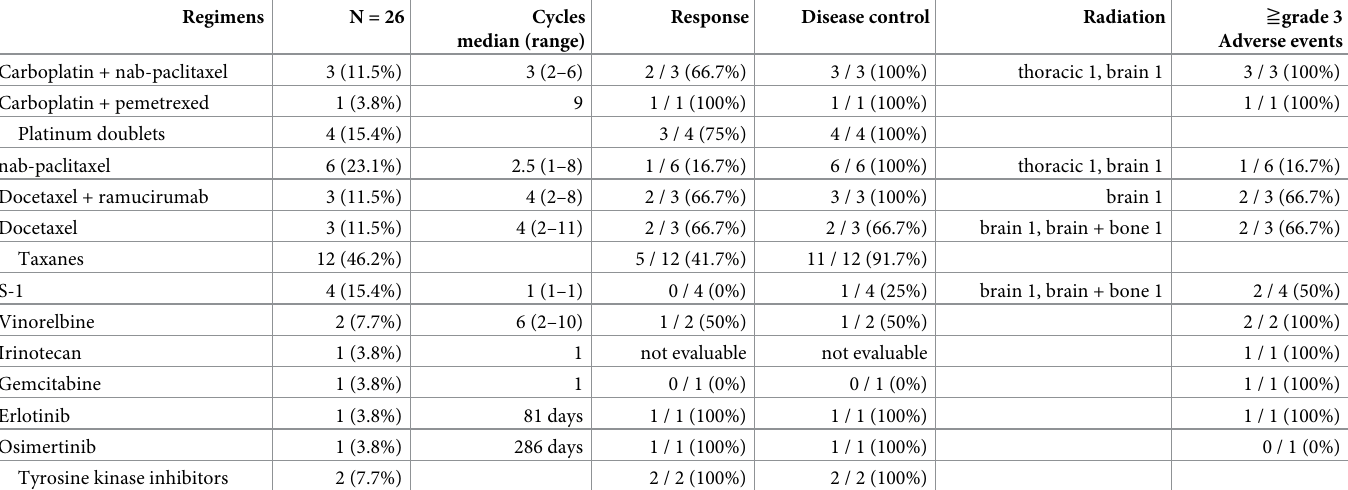
Table 3. Result of each treatment regimens.